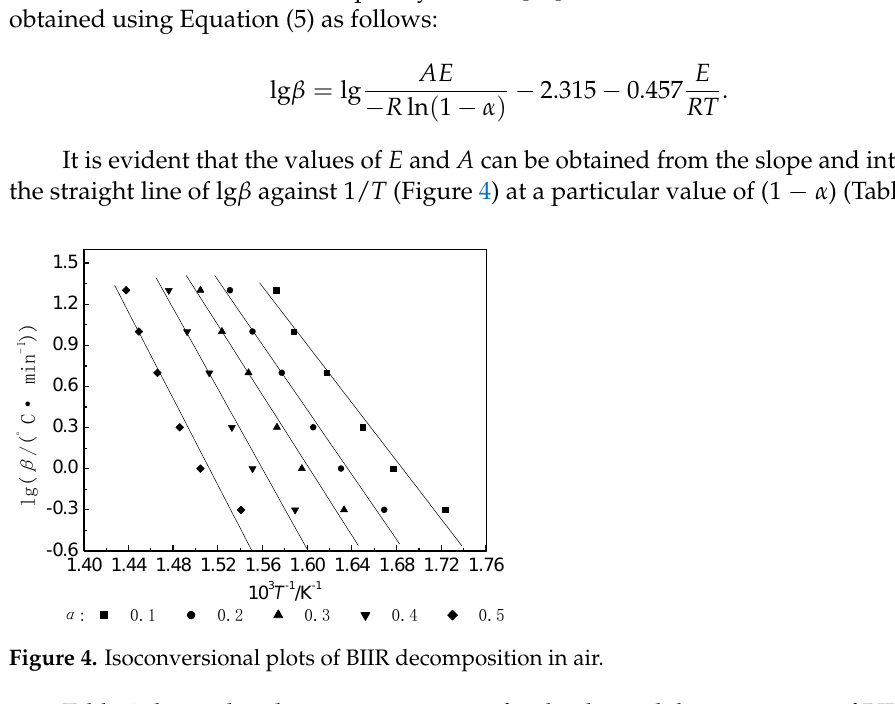
Table 4. Apparent activation energy ( E ) and frequency factor ( A ) at different fractional mass loss ( α ) values for BIIR decomposition in